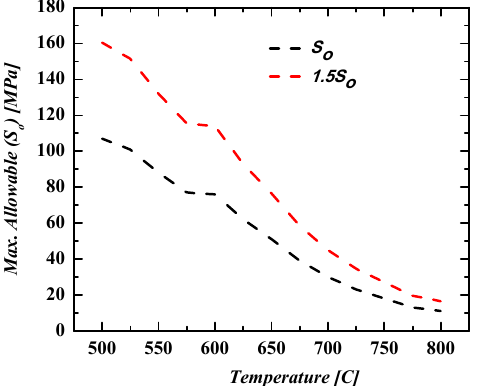
Figure 8. Stress classification line for stress linearization method.